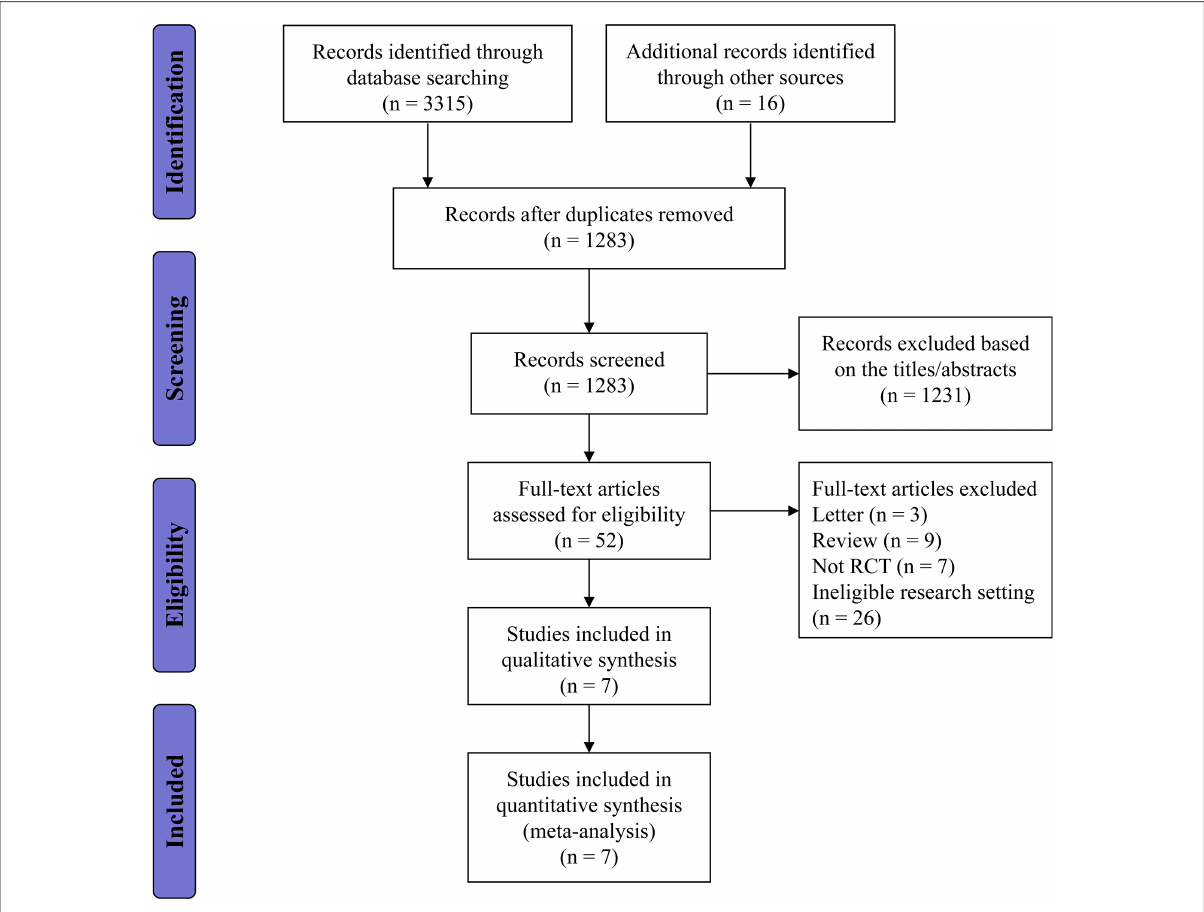
FIGURE 1 Study fl ow diagram showing the number of records identi fi ed and excluded at each